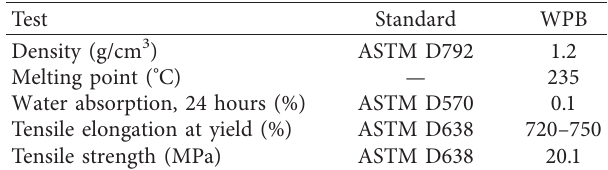
Table 2: Properties of the